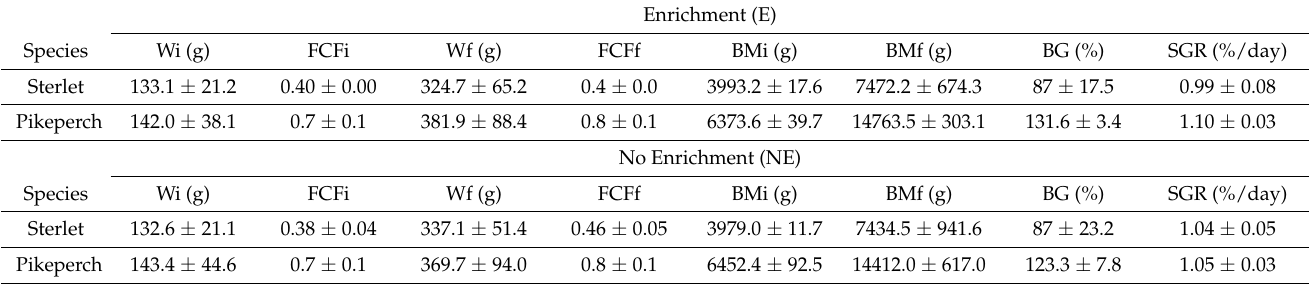
Table 1. Fish growth data (mean ± standard deviation) for the two species, sterlet ( Acipenser ruthenus ) and pikeperch ( Sander lucioperca ), reared with or without enrichment (E and NE, respectively). Enrichment